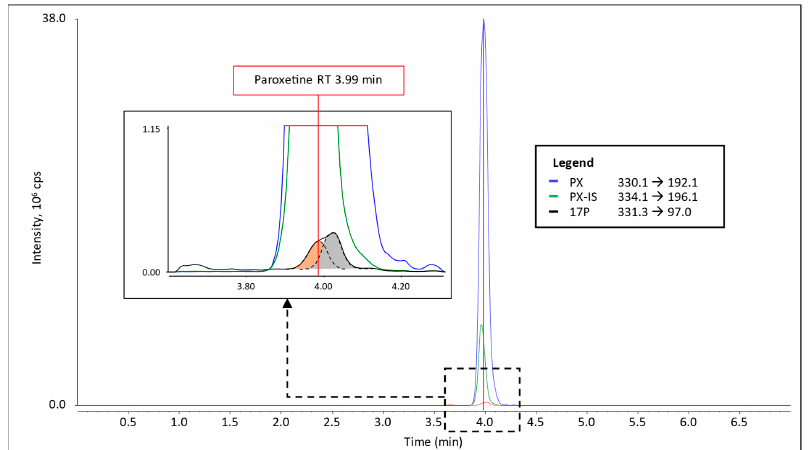
Figure 1. Ion trace chromatograms of a quality control sample of TDM kit “antidepressant panel 1” (Chromsystems) containing PX, PX-IS and 17P. The 17P ion transition is enlarged in the inset box. The 17P peak (grey) has a shoulder originating from co-eluting PX (orange). The retention time of the PX signal in the specific ion transition (330 192) is marked with a red line. When analyzing patient samples from routine TDM testing with a known PX con- centration, an additional signal was found in both 17P ion transition chromatograms. However, in this experiment, PX was well separated from the 17P signal with the only difference being that another column (new LOT) was used (see Figure 2).